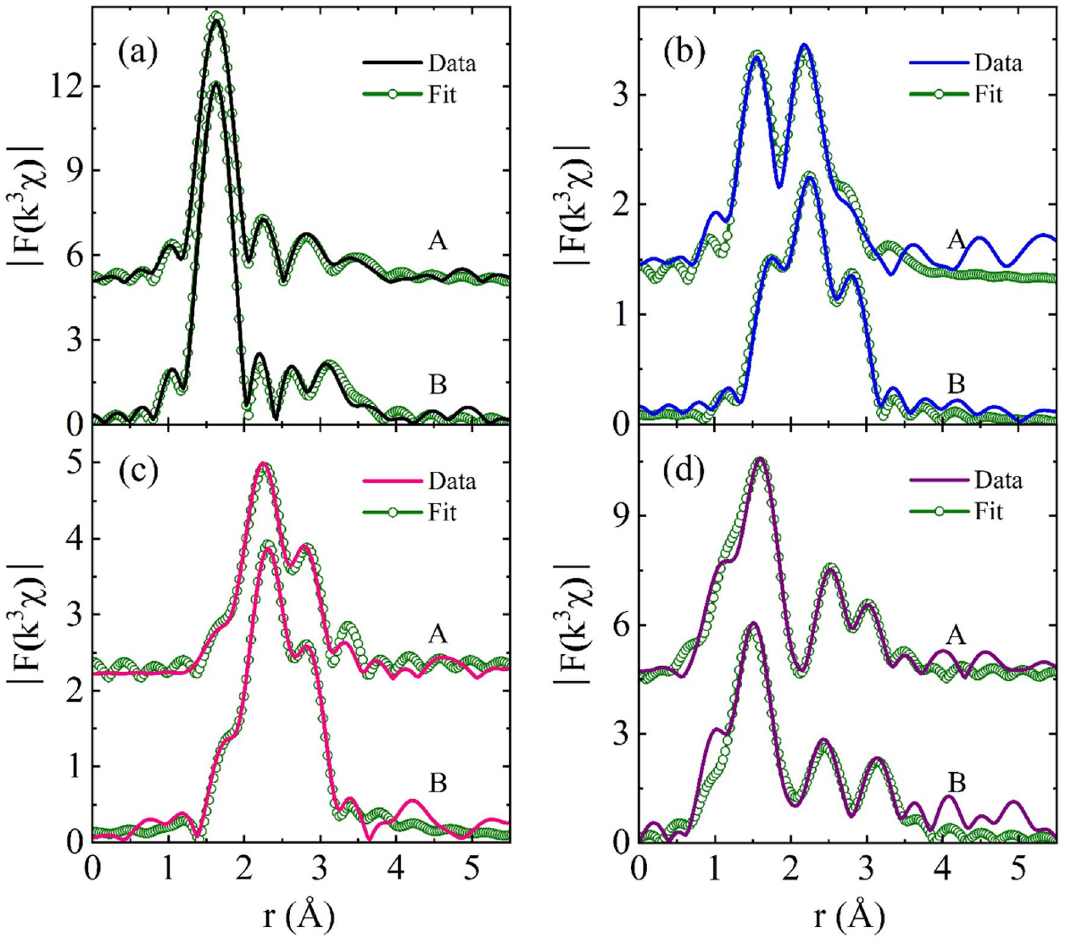
Figure 5. Representative FT-EXAFS data and the best fits. At the Pt L 3 edge of A Pt/Ti–FS and B H 2 O 2 -Pt/Ti– FS at different temperatures of ( a ) RT, ( b ) 200 °C, and ( c ) RT c , respectively. ( d ) At the Ti K edge of Pt/Ti–FS and H 2 O 2 -Pt/Ti–FS at 250 °C. Data in the r-ranges from 1.3 – 3.5 Å and from 1.3 – 4.3 Å were respectively fitted for the Pt L 3 and Ti K edges.